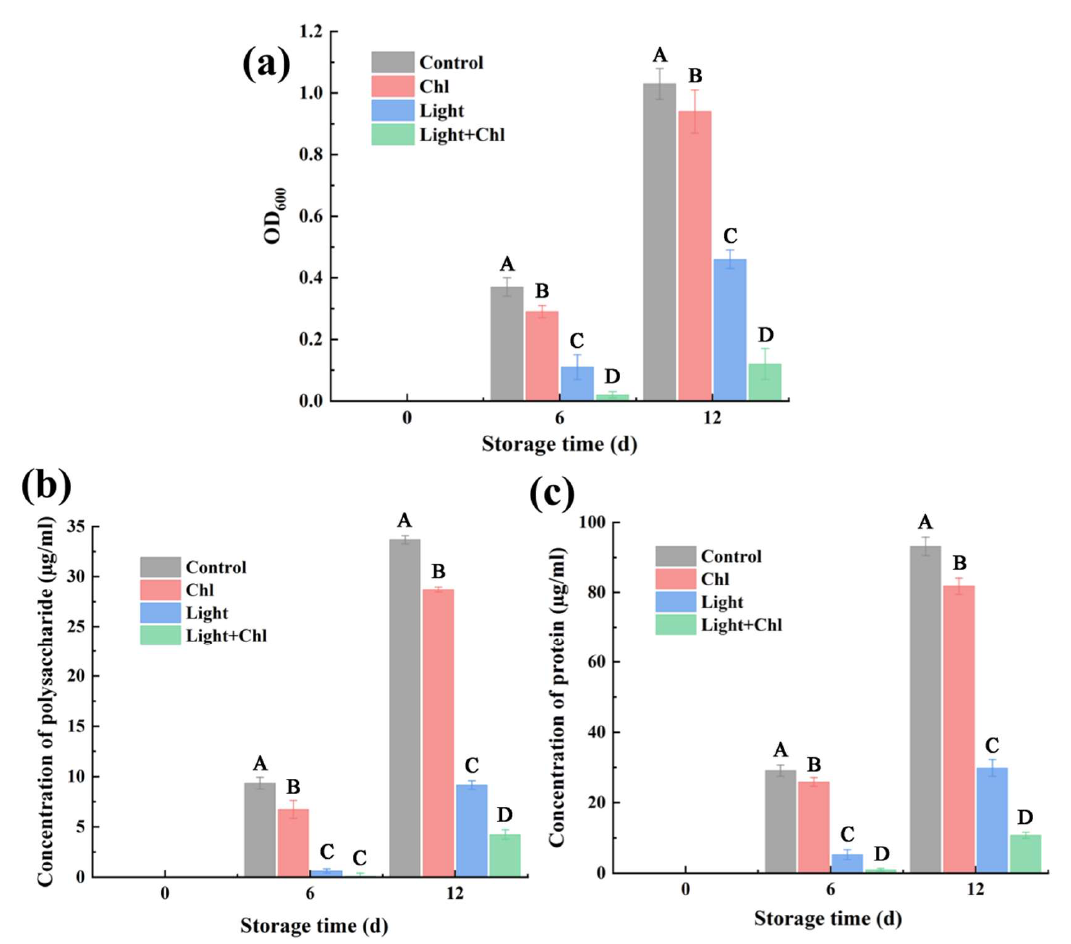
Figure 5. The biofilms’ formation on samples ( a ). The effect of Chl-based PDI on extracellular polysaccharides’ concentration ( b ) and extracellular protein concentration ( c ). A, B, C, and D mean significantly different in groups ( p < 0.05). Error bars represent the mean ± SE ( n = 3).